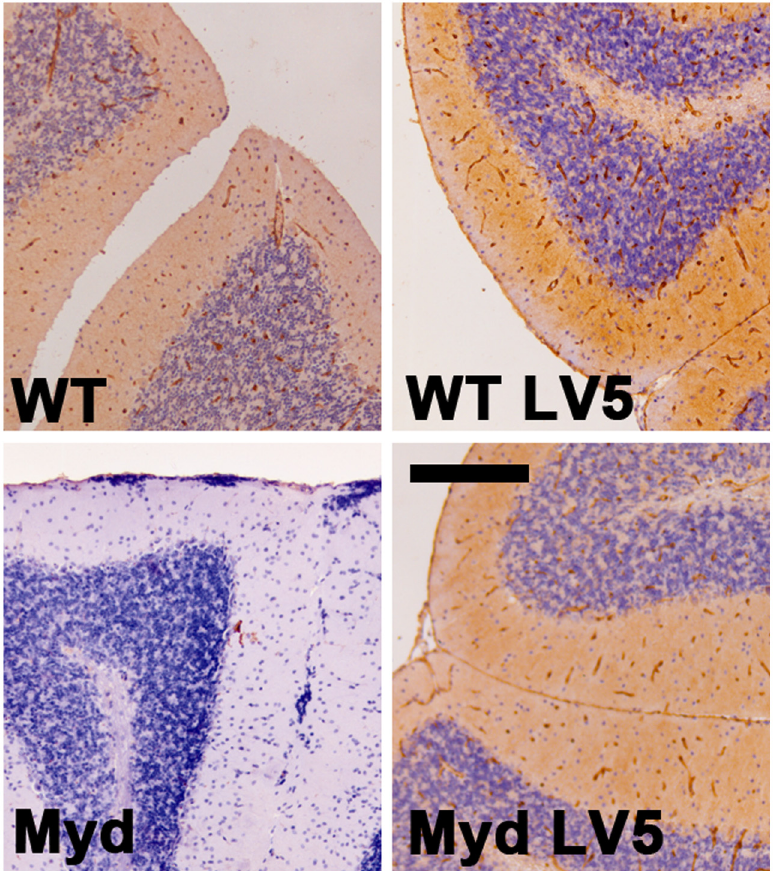
Fig 6. The LARGE-LV5 transgene restores IIH6 reactivity and confers a diffuse global increase in the epitope in brains. IIH6 immunostaining of cerebellar sections of brains from wild type, WT-LV5, LARGE myd and LARGE myd -LV5 mice (as indicated). IIH6 reactivity is observed in blood vessels and the pia in WT, WT-LV5 and LARGE myd -LV5 cerebellum, but not in brains of LARGE myd mice. Overall stain intensity is higher in LV5 transgenic mice than in WT controls. Bar: 200 μ m.